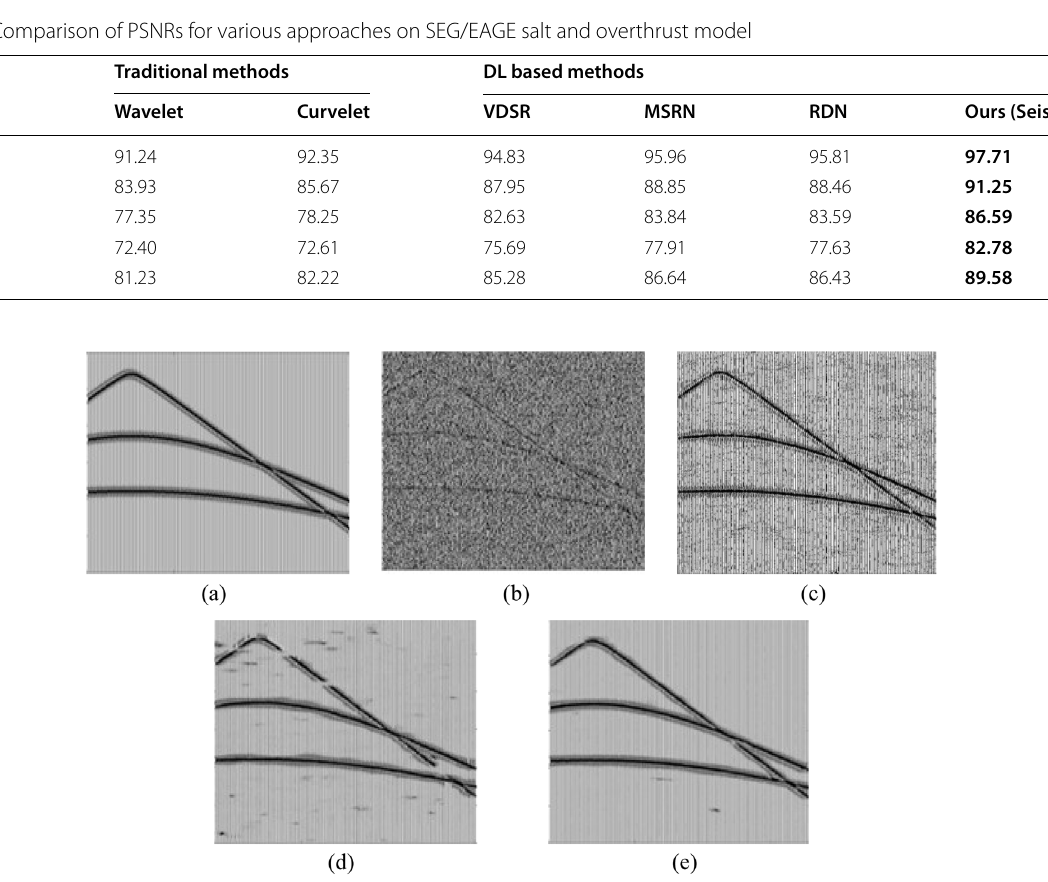
Fig. 6 Synthetic seismic data denoising. a Clear seismic data. b Seismic data with added strong random noise (PSNR: 68.1319 dB). Denoised seismic data by ( c ) curvelet-based threshold denoising (PSNR: 83.1581 dB), ( d ) RDN (PSNR: 89.8995 dB) and ( e ) the proposed approach (PSNR: 91.6652